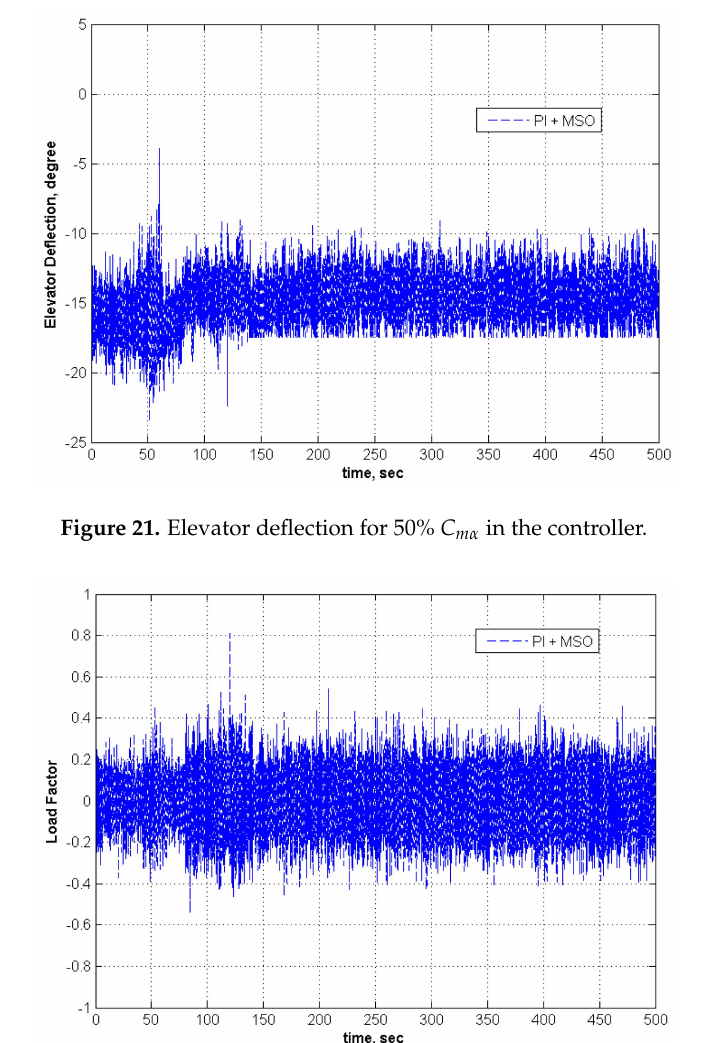
Figure 20. Pitch rate response for 50% C m α in the controller.